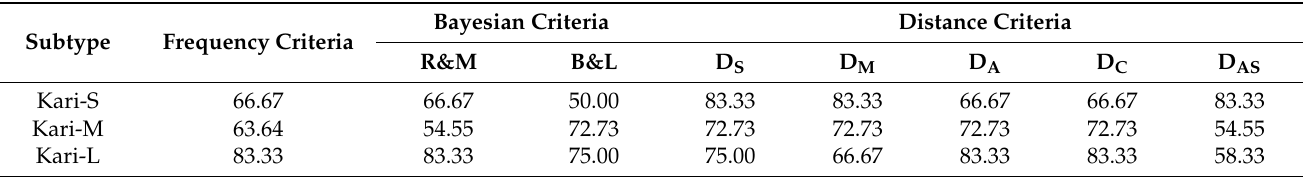
Table 3. The average probability of individuals correctly assigned to their respective subtype using different statistical criteria.